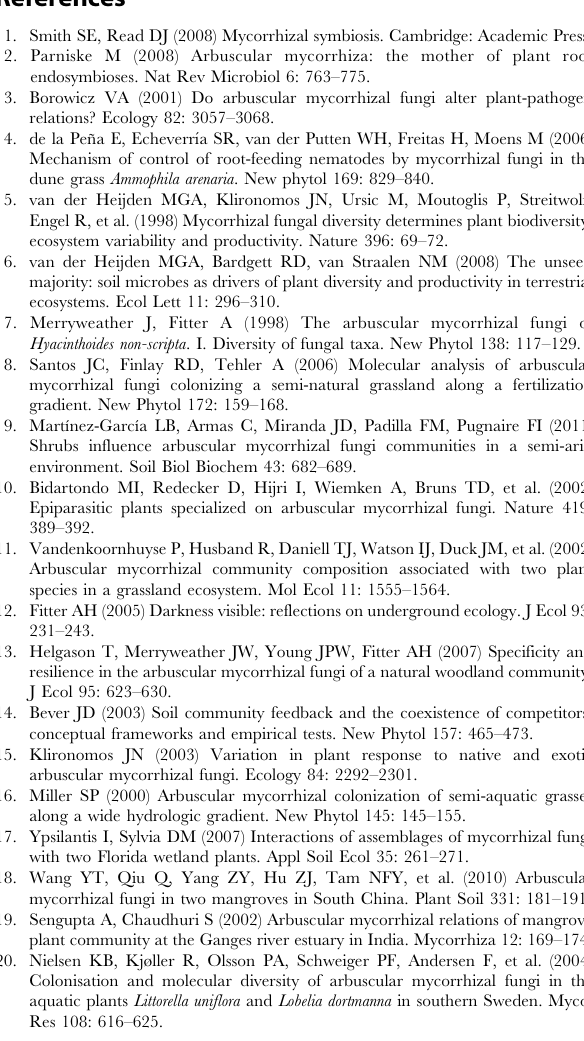
Table S2 BLAST results for the unidentified environmental sequences from GenBank related to the phylotypes obtained in this study. (DOC) Alignment S1 Sequence alignment of the representative se- quences from each OTU obtained in this study and the representative AMF sequences from GenBank. Alignment S2 Sequence alignment of the sequences from phylotypes Glo1–Glo4 and their related sequences in